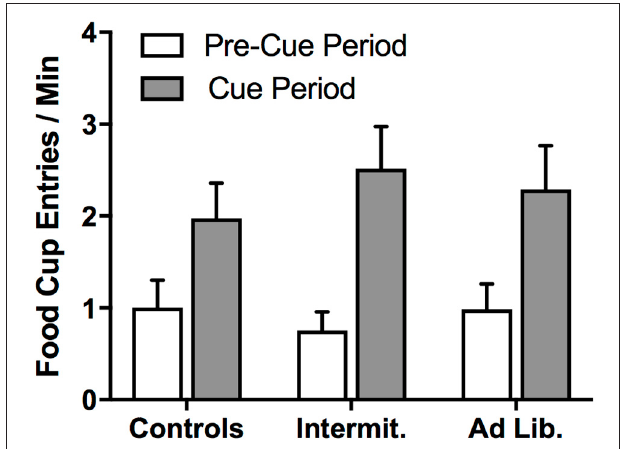
FIGURE 6 | Food cup entries during the PIT test. All groups showed similar levels of conditioned approach food cup entries, suggesting that diet did not alter food cup approach in response to cues. Means ±